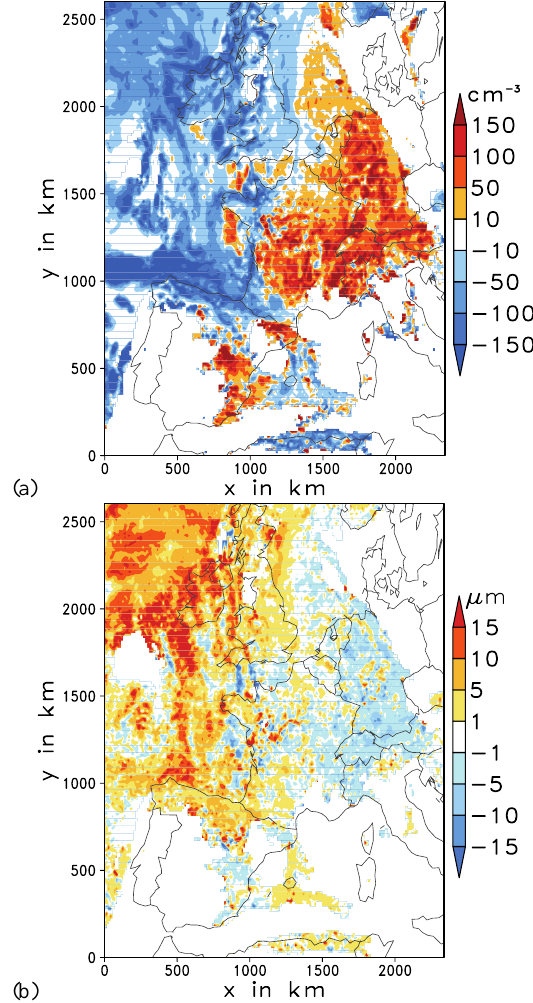
Fig. 8. Difference in the (a) average CDN concentration and (b) the average mean cloud droplet diameter between simulation A and B for 0 to 1500ma.s.l. and 19–20 August